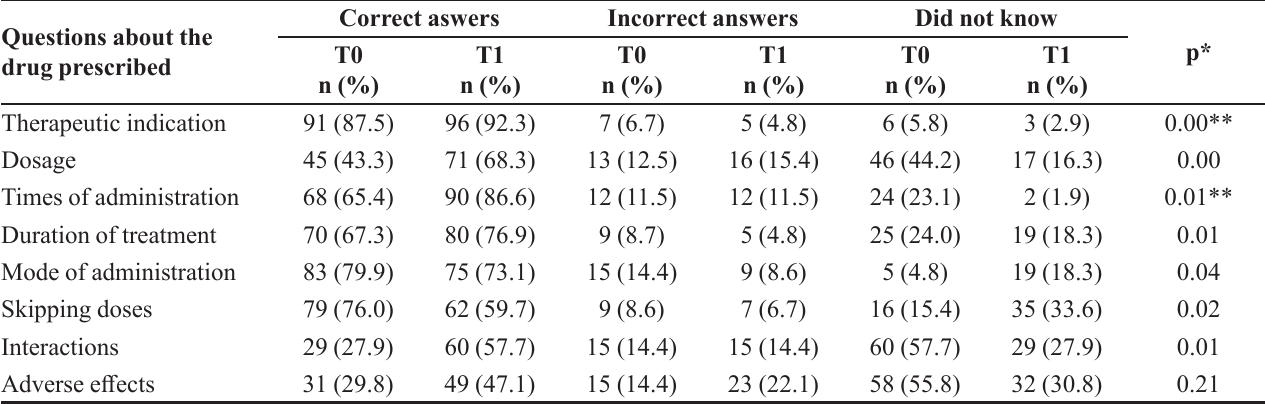
TABLE IV – Comparison of level of knowledge before (T0) and after (T1) drug dispensation at the University Pharmacy of the Federal University of Goias, 2013 (n=104) Questions about